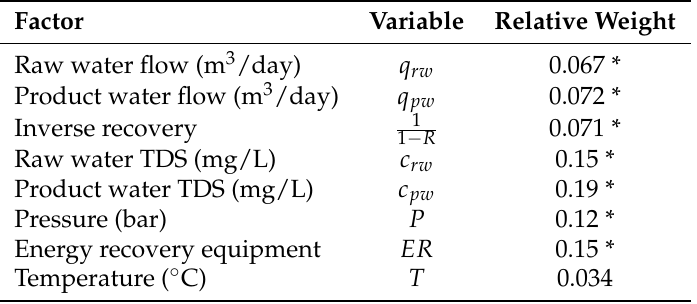
Table 4. Relative importance analysis results for the small-scale model of desalination operations ( n = 45) revealed a strong dependence on water quality, pressure, and use of energy recovery equipment. Values have been rounded to two significant